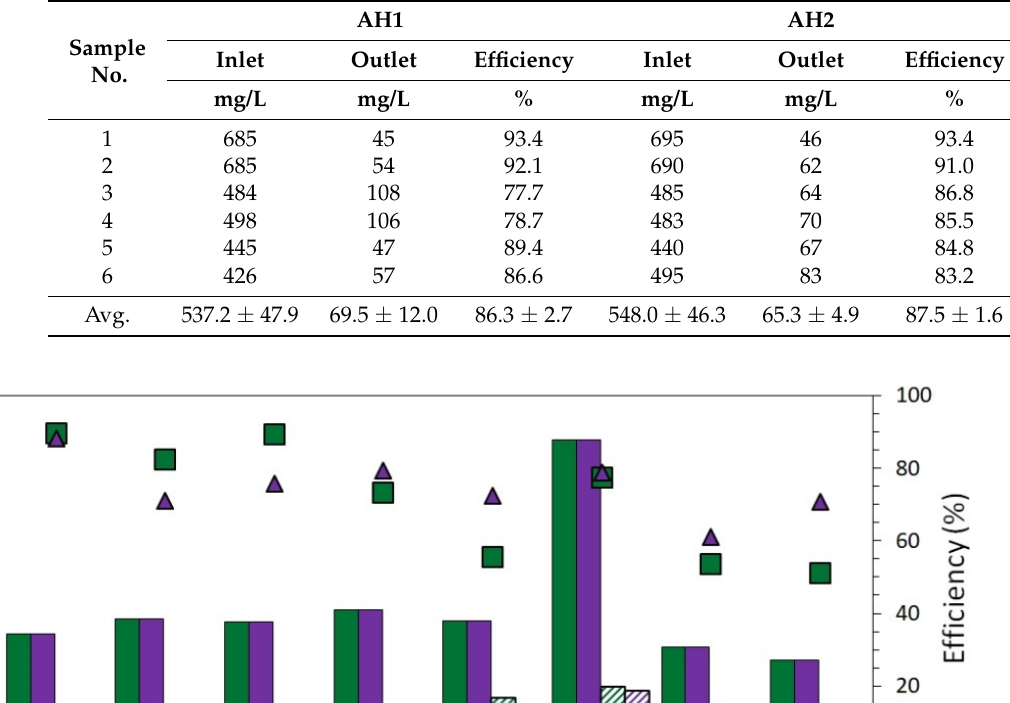
Table 3. Inlet and outlet COD and removal efficiencies at stage II.